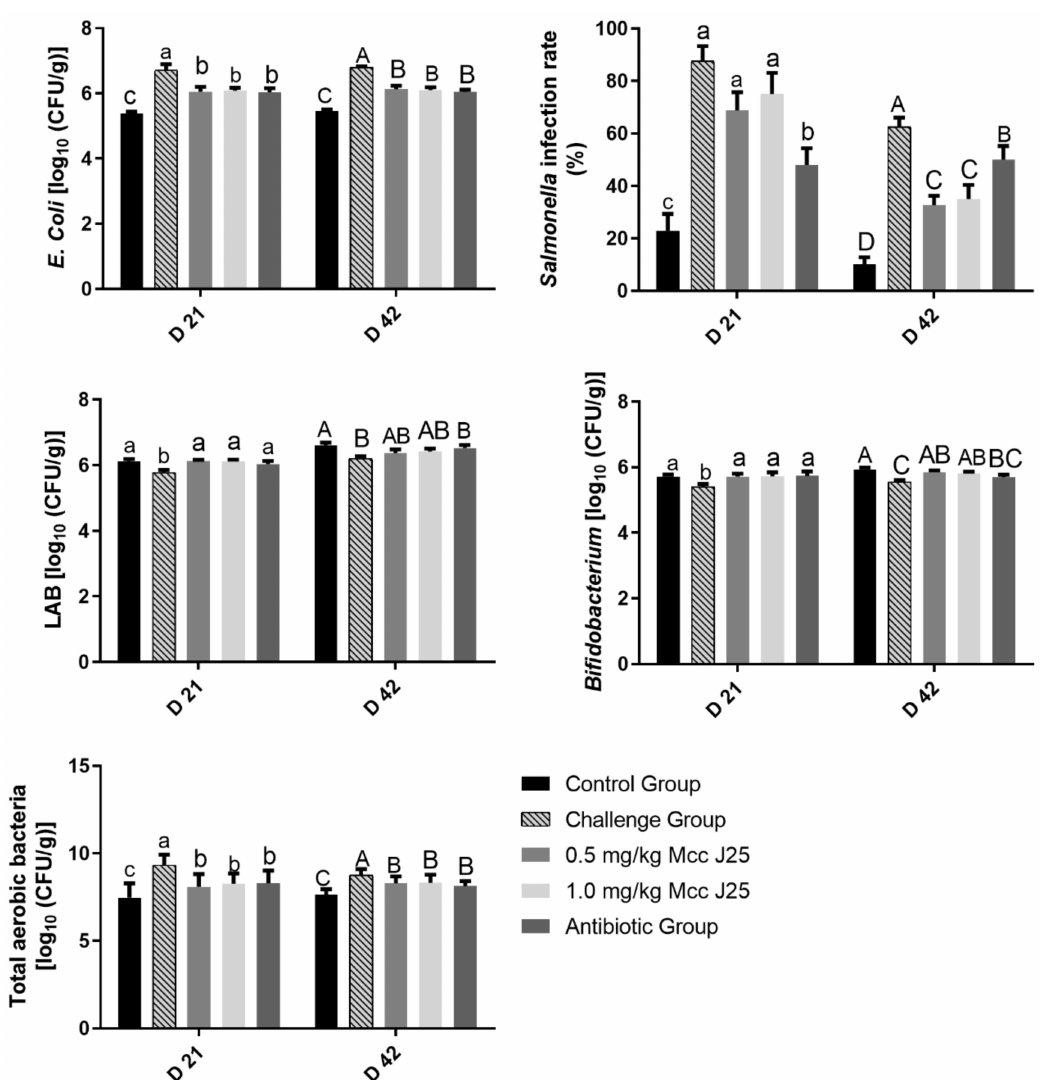
Figure 1. E ff ects of MccJ25 on Escherichia coli ( E. Coli ), lactic acid bacteria (LAB), Bifidobacterium counts (log 10 cfu / g), and total aerobic bacteria in the feces, as well as the Salmonella infection rate in broilers on days 21 and 42. Bars represent means ± SEM for 12 broilers per treatment. Within the same day, bars with di ff erent letters di ff er significantly ( p <